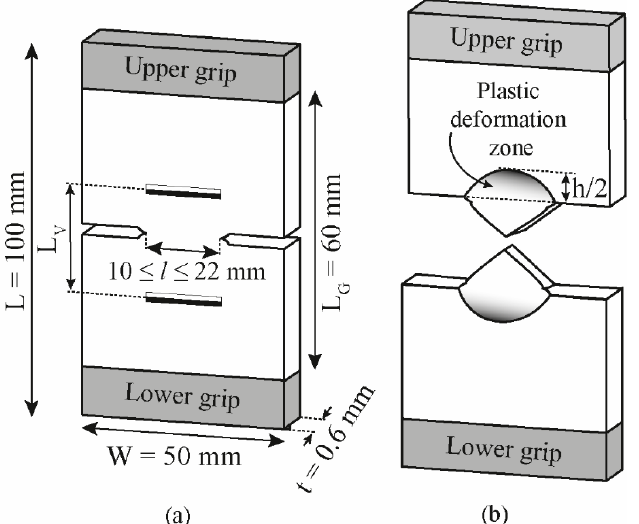
Figure 1. Schematic representation of the deeply double-edge notched tensile (DDENT) geometry with sample dimensions ( a ) before and ( b ) after testing.